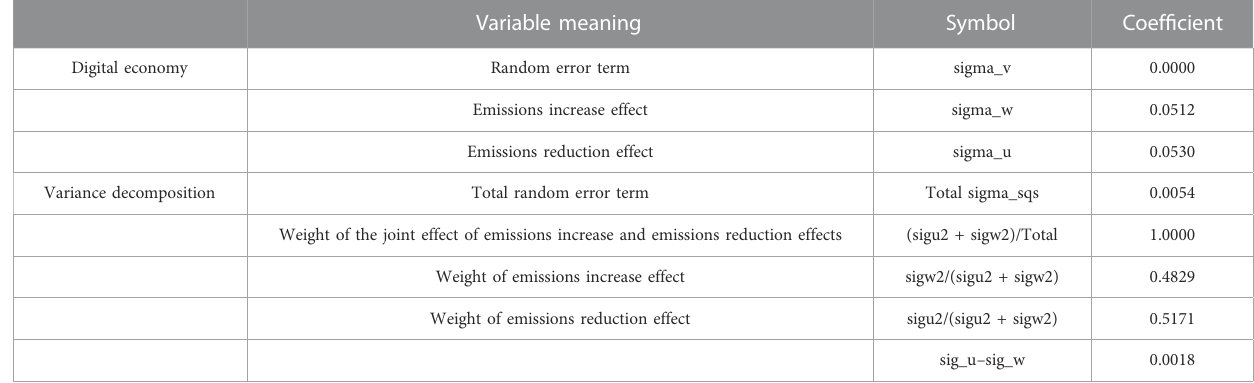
TABLE 3 Variance decomposition: Emissions increase and emissions reduction effects of digital economy on air pollution.